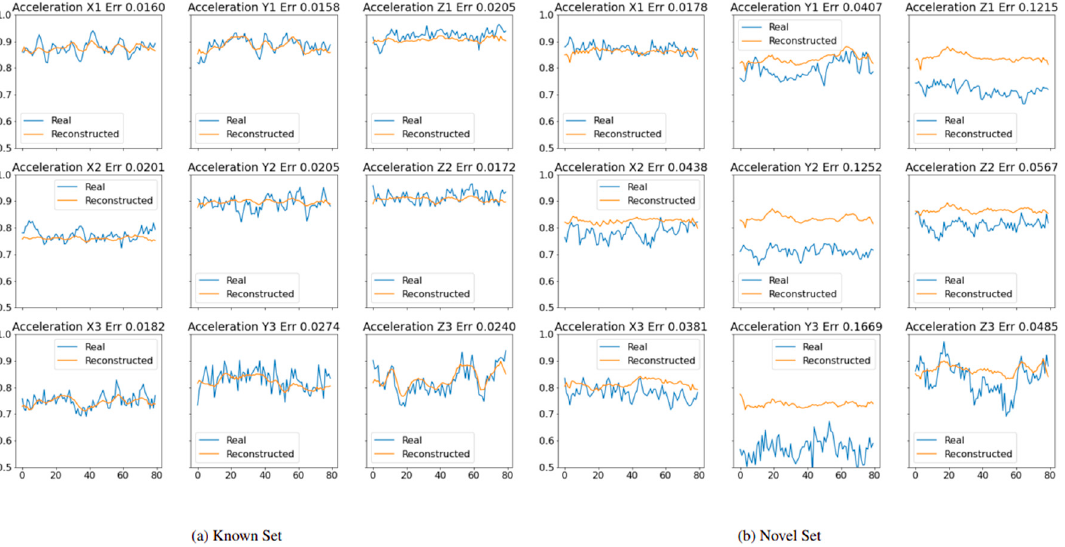
Figure 2. The reconstruction performed by the Localizer of signals describing an already seen ( a ) or a novel operating condition ( b